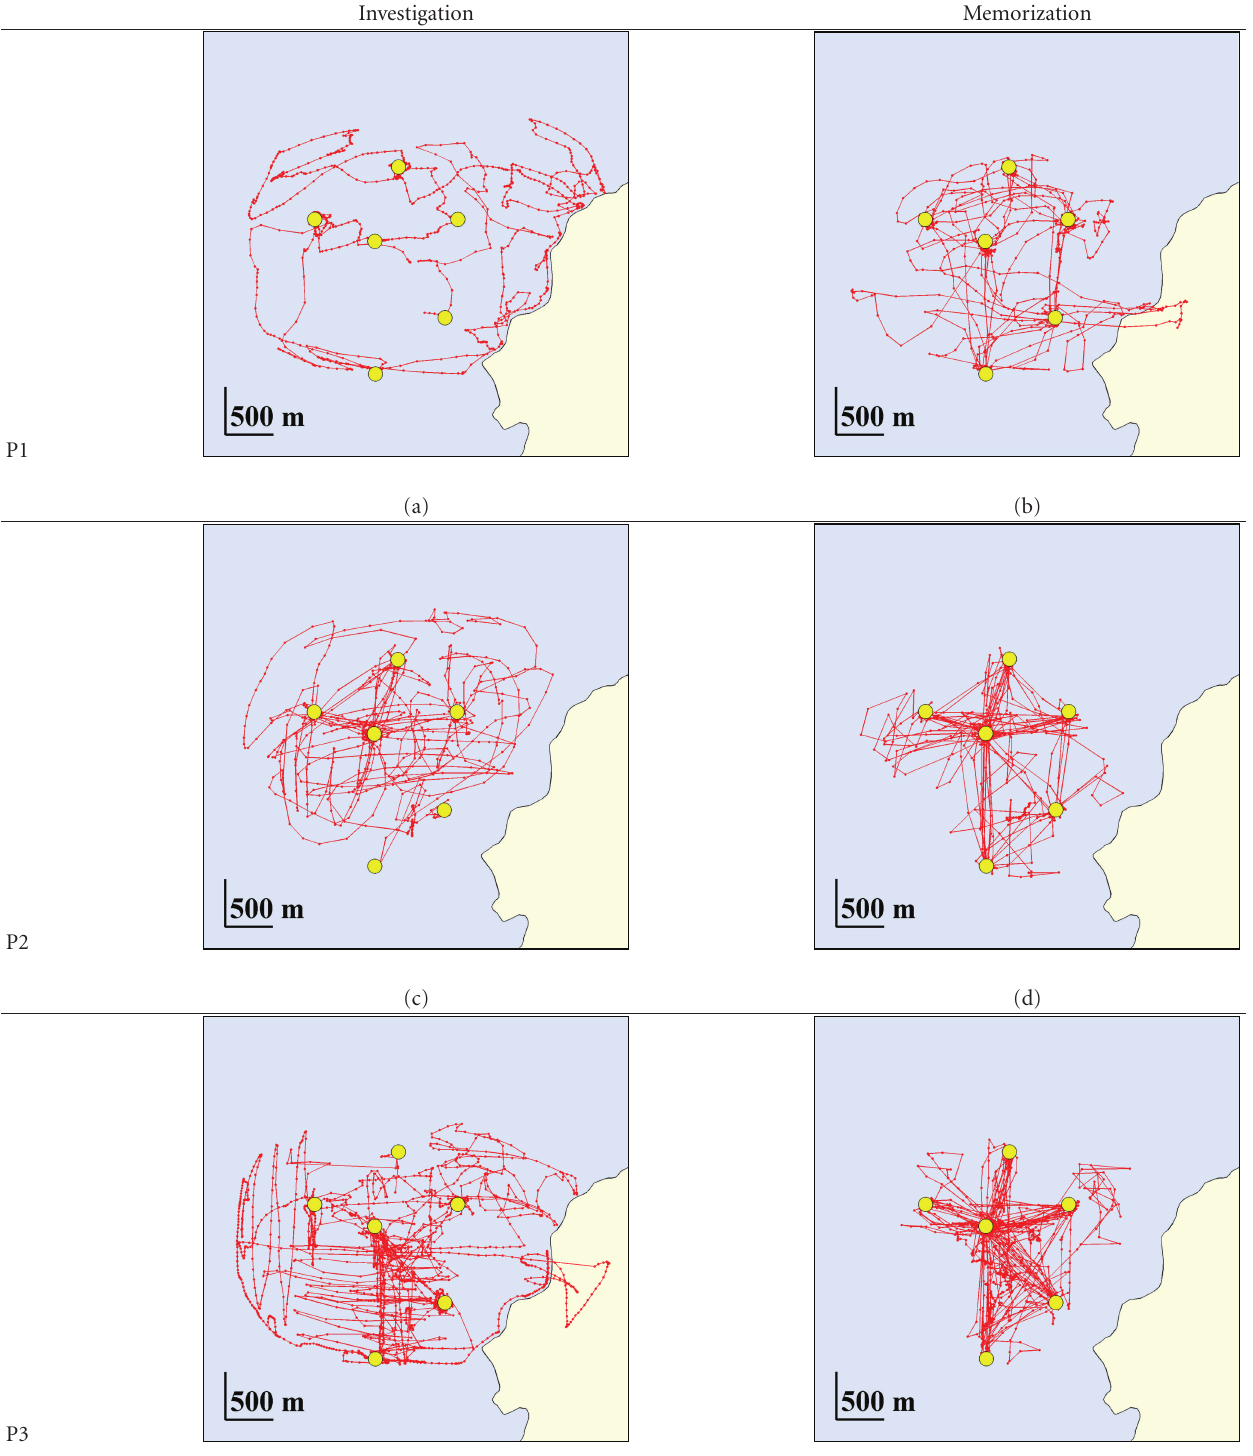
Table 3: (from (a–f)) Investigation and memorization phases tracks of participants 1, 2, and 3. Virtual map (land area in pale yellow, sea in blue and beacons in dark yellow circles) and exploration trajectories (thin red lines) during the investigation (left) and memorization (right) phases for each